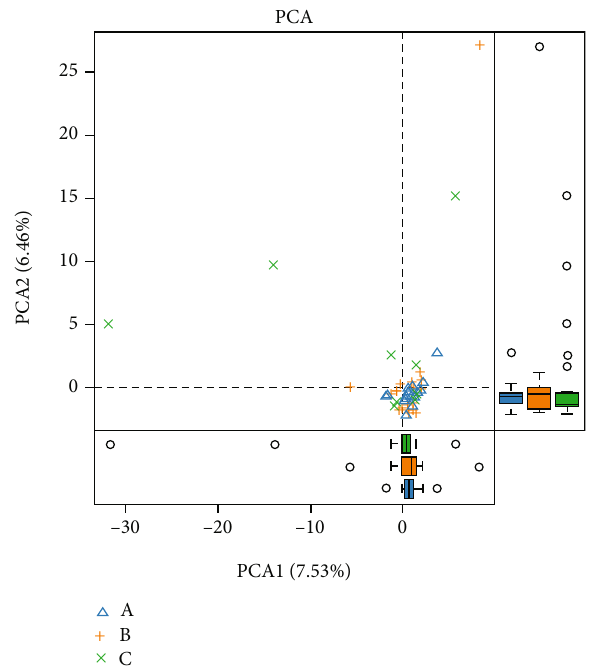
Figure 4: PCA and PCoA distance function. Visualization of PCA and PCoA results for fecal samples from groups A, B, and C.